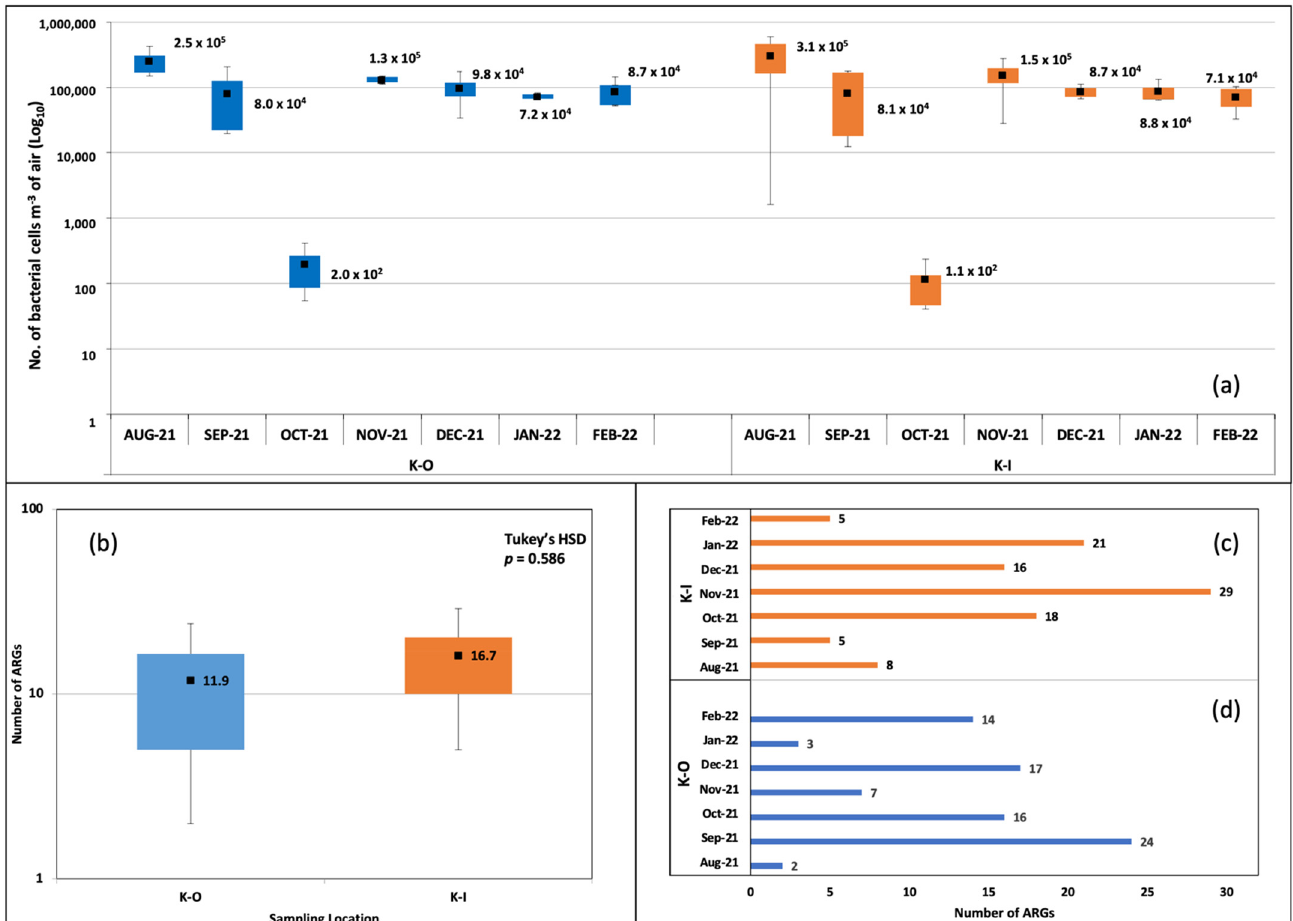
Figure 1. Bacterial cell counts and number of ARGs detected in indoor and outdoor bioaerosols. ( a ) Box plot showing the number of bacterial cells per m − 3 of air. ( b ) Box plot comparing the mean number of ARGs. ( c ) Number of ARGs in indoor aerosols at the di ff erent months of sampling. ( d ) Number of ARGs in outdoor aerosols at the di ff erent months of sampling.